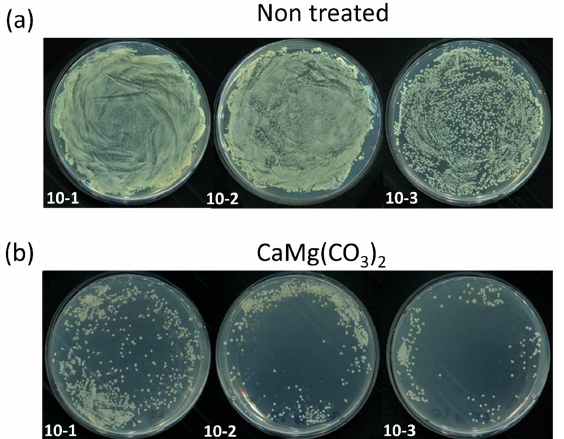
Figure 2. The antibacterial activity of the CaMg(CO 3 ) 2 on E. coli . ( a ) Control group, ( b ) CaMg(CO 3 ) 2 - treated group.